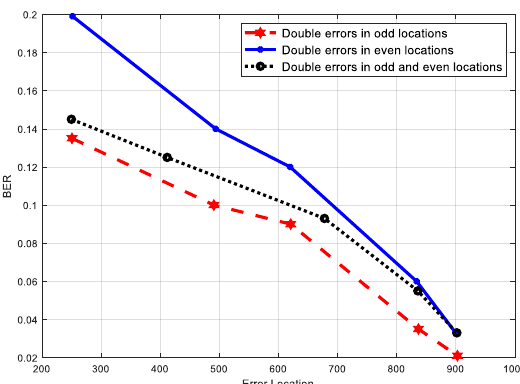
Figure 10 The effects of double errors on even locations only, on odd locations only, and one at even and one at odd